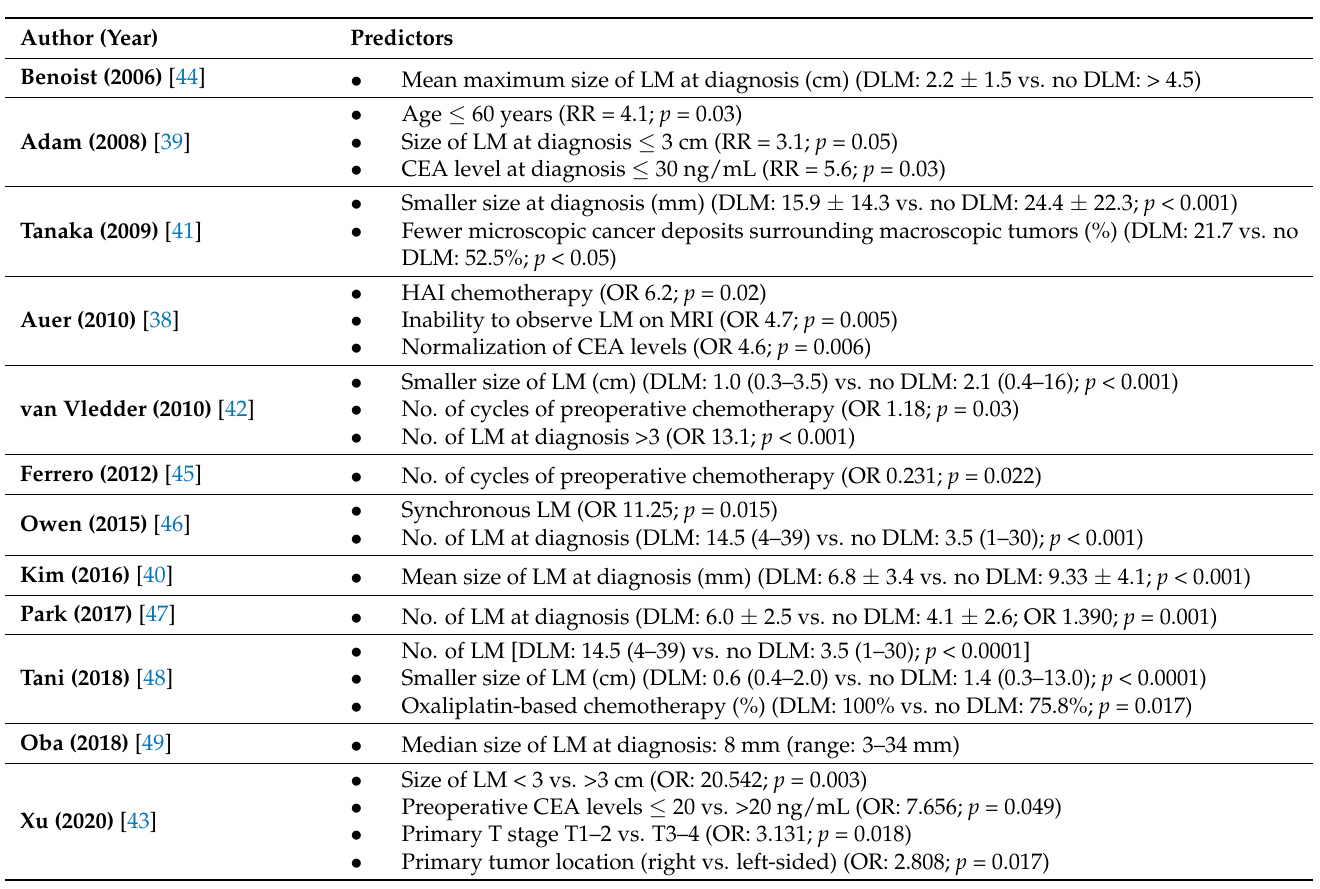
Table 1. Predictive factors of DLM and complete response. LM: liver metastasis, DLM: disappearing liver metastasis, RR: risk ratio; CEA: carcinoembryonic antigen; HAI: Hepatic arterial infusion; OR: Odd ratio.